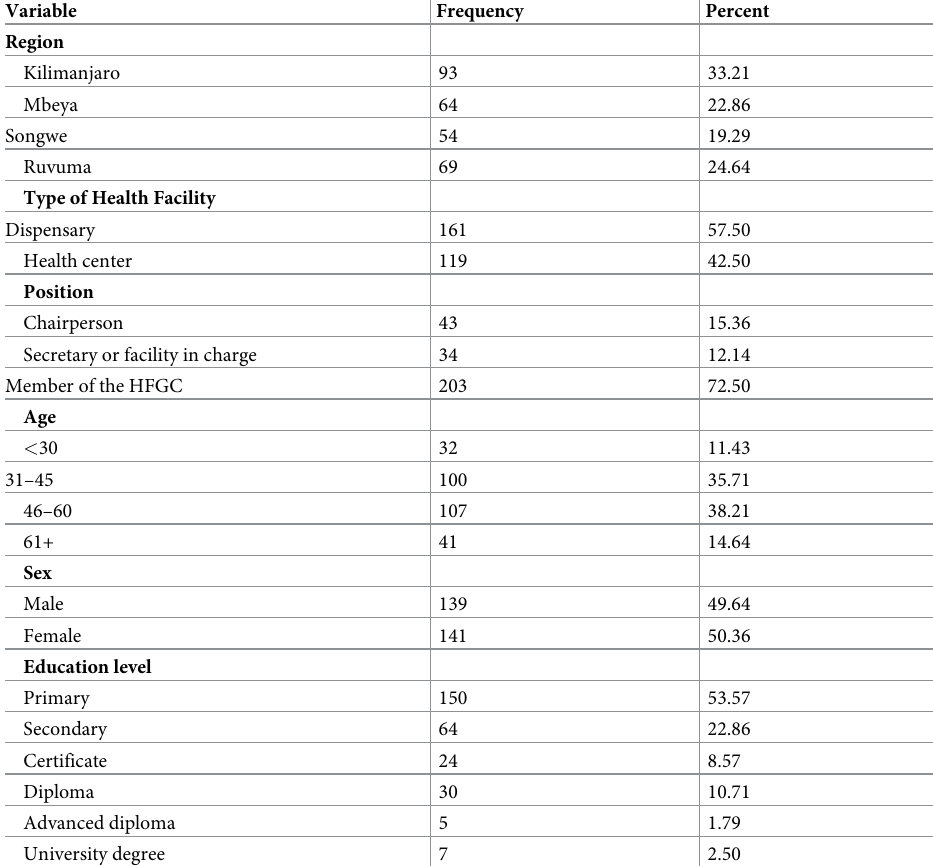
Table 2. Demographic characteristics of HFGs members N =